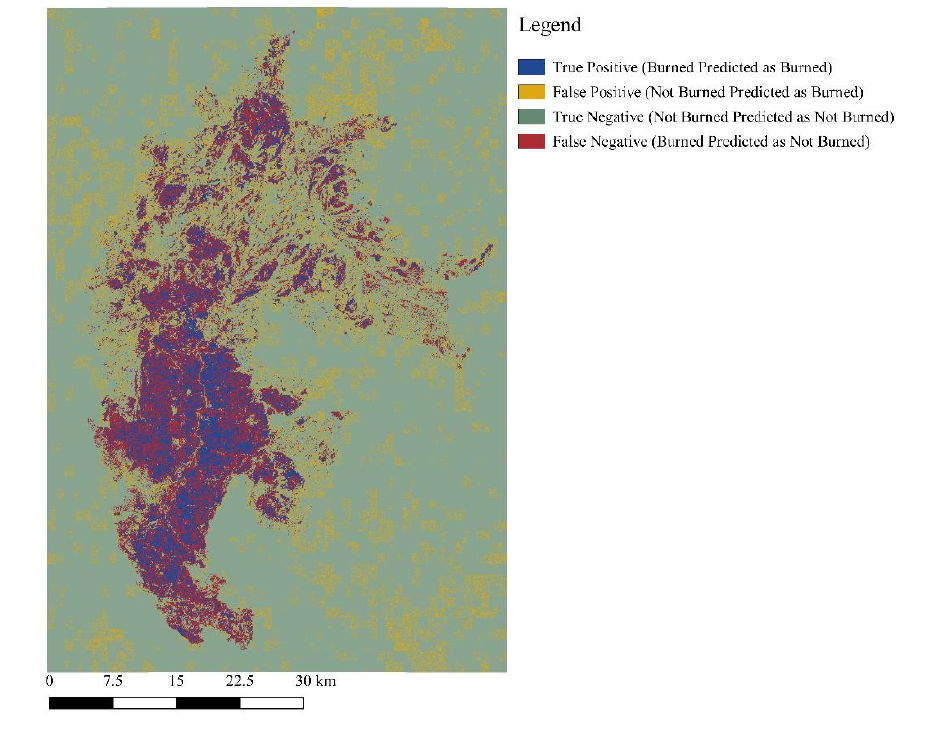
Figure 11. U-Net_Transfer segmentation results on the Creek Fire study area.